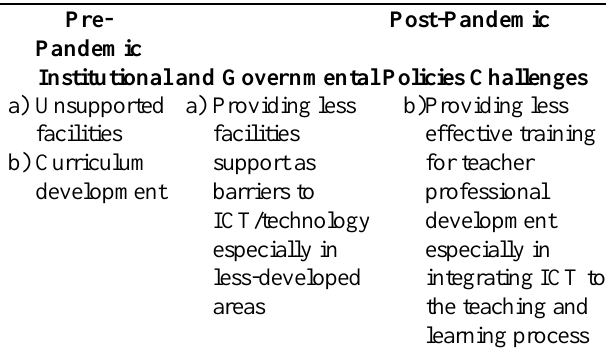
TABLE 10 | Institutional and Governmental Policies